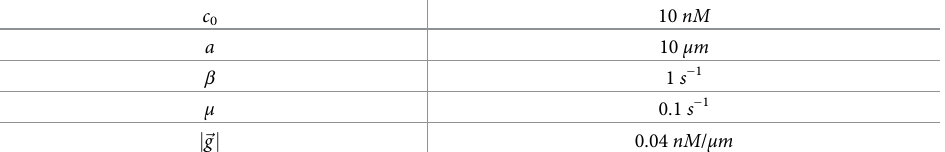
Table 1. Parameter values. c 0 is the background concentration, a is the typical linear size of a cell, β and μ are the pro- duction and degradation rates of the reporters, j ~ g j is the slope of the gradient [18, 19, 43].